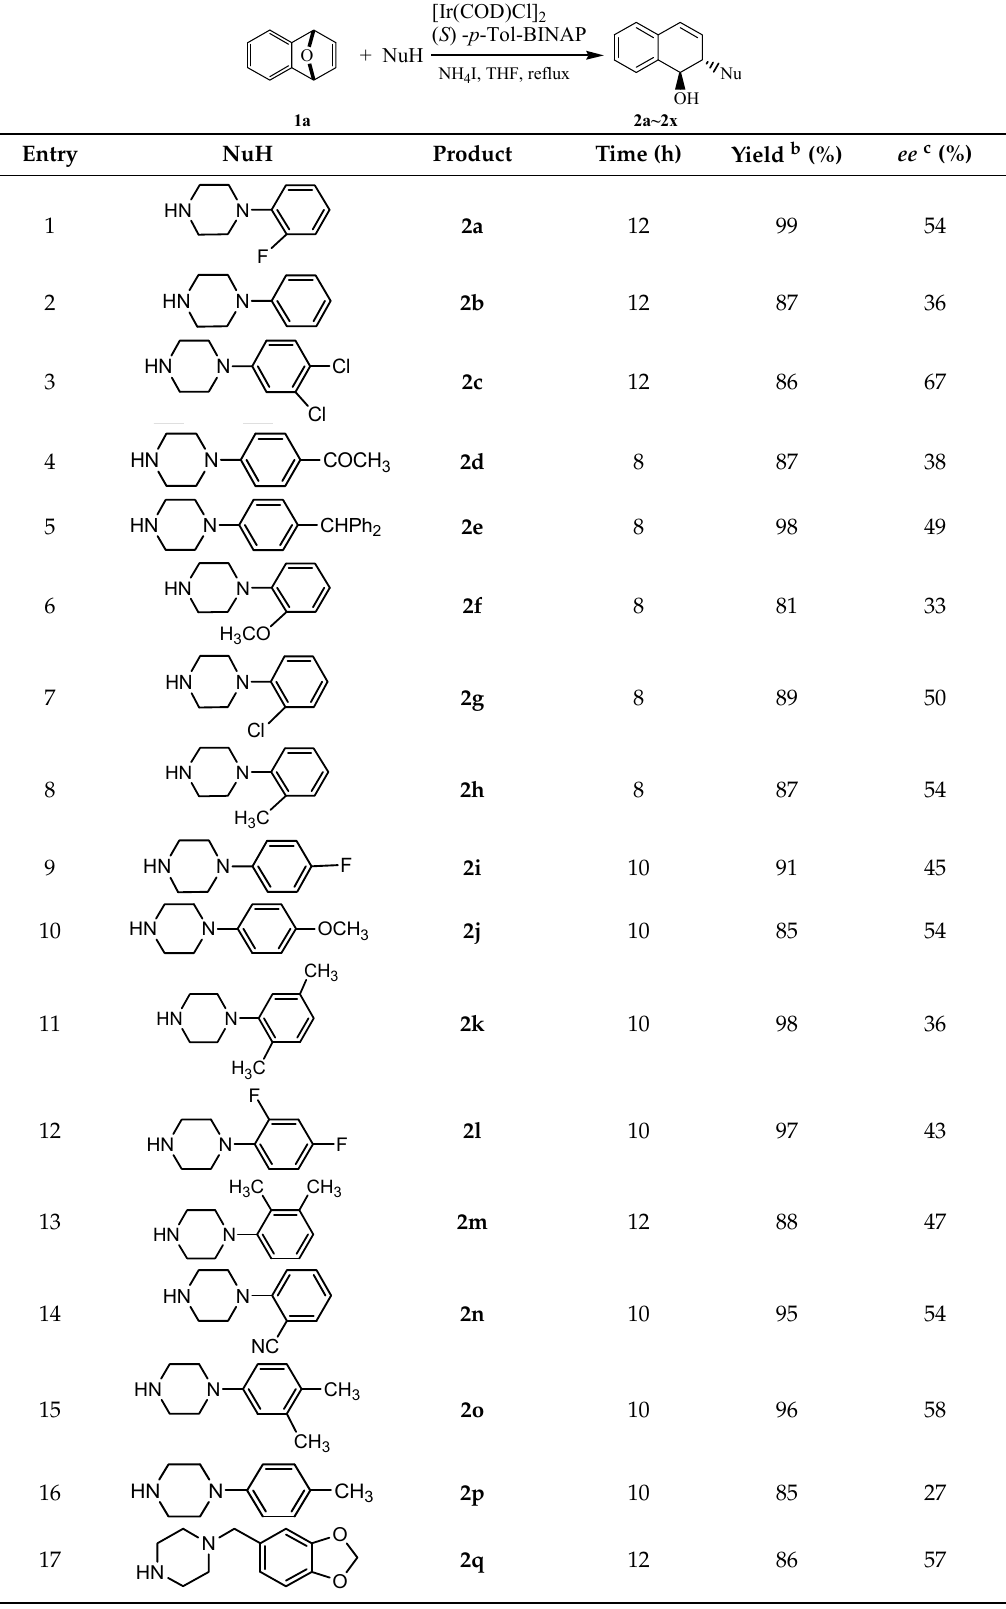
Table 4. Iridium-catalyzed asymmetric ring-opening of oxabenzonorbornadiene 1a with N -substituted piperazines a .